Question: What does this figure show? Answer in one sentence.
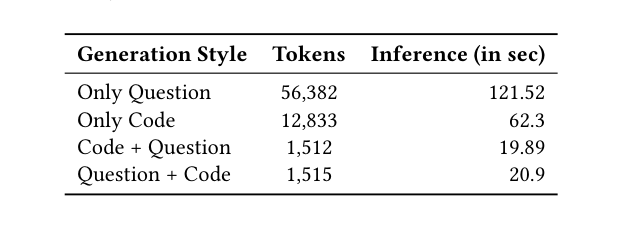
Answer: shows that generating questions only and then translat- ing to code yields higher alignment (93%). Two drawbacks of this approach are diversity and cost. Table 4 shows the average number of tokens and associated inference time for different approaches. Generating questions and code together is 37 times cheaper and six times faster than generation questions and translating them. Figure 7 shows that initial generations are diverse, but we see diminishing returns form generating more insights. After around 20 insights, the questions becomes more repetitive. Surprisingly, this effect is stronger for tables with more columns. We find that the model repeats the the exact same insight for multiple columns.